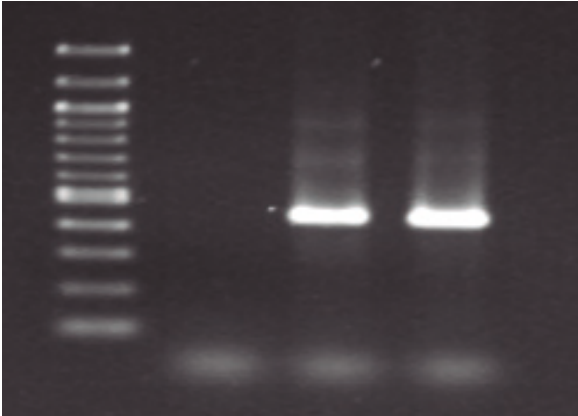
Figure 1. Amplification of the 440 bp fragment of the env gene by the polymerase chain reaction technique.